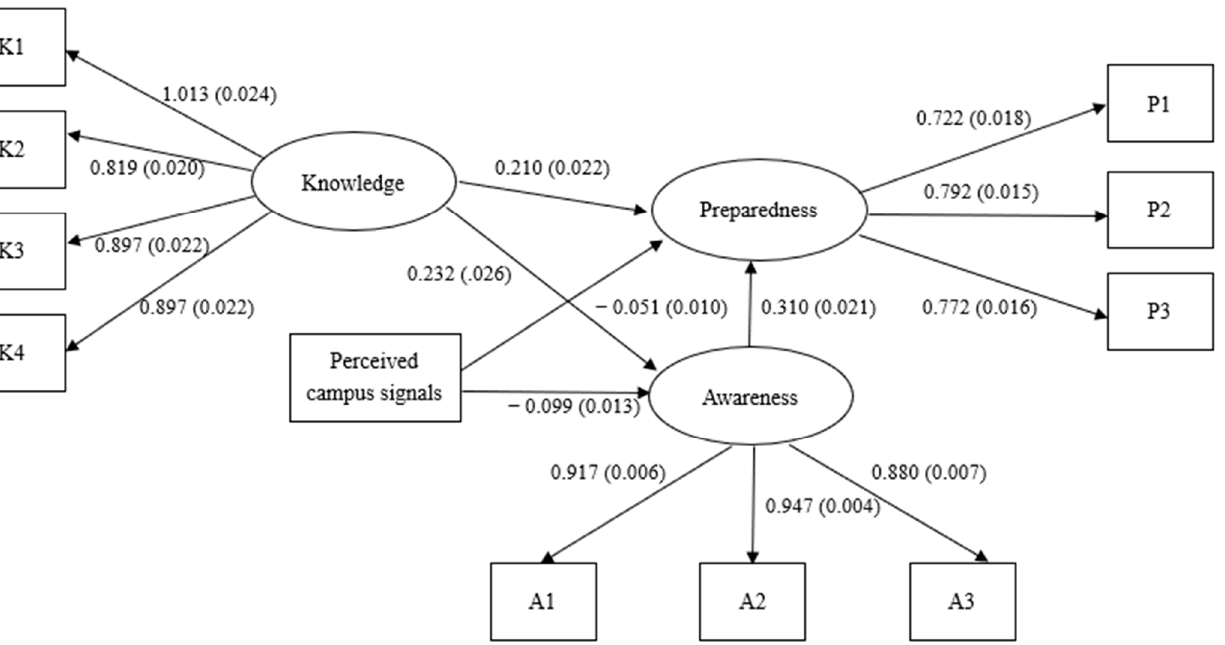
Figure 1. Final full structural regression model of students’ perceived anti-epidemic campus signals on their COVID-19 preparedness. Note: The factor loadings were reported by using standardized results, while the path coefficients were reported by using unstandardized results for an easier interpretation; standard errors are in parentheses. Table 5. Full structural regression model of students’ perceived anti-epidemic campus signals on their COVID-19 prepared- ness with control variables.